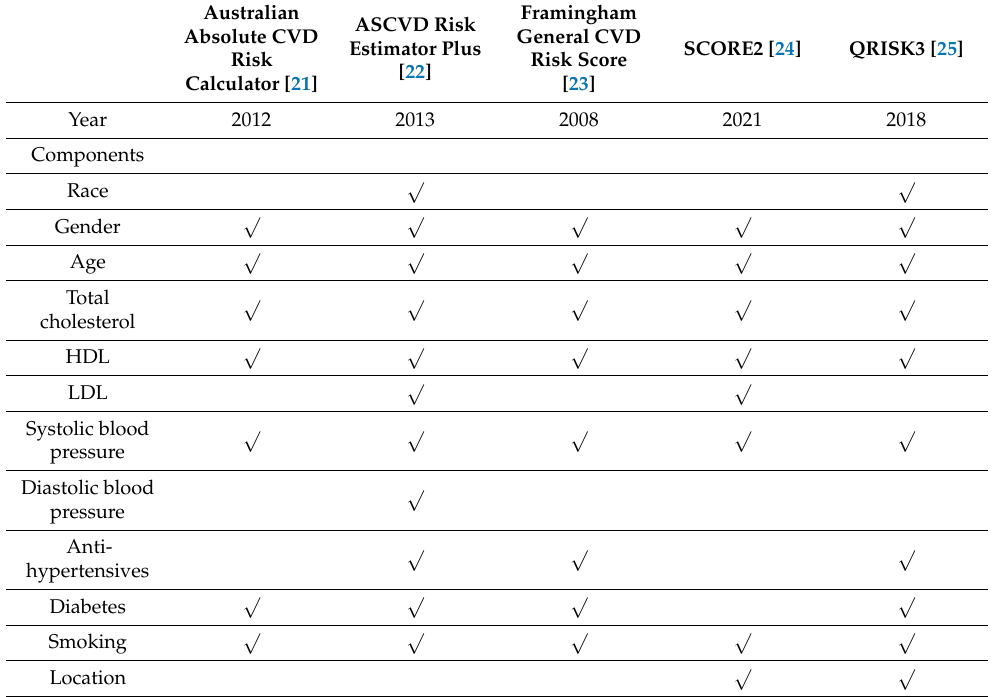
Table 1. A summary of some of the available primary prevention risk